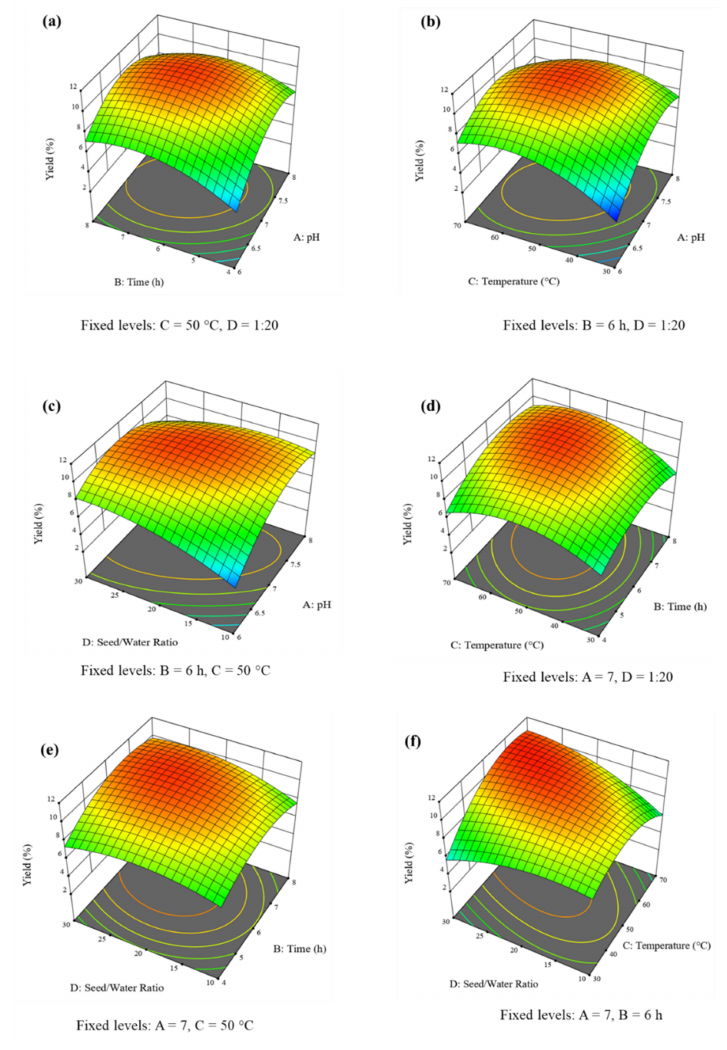
Figure 2. 3D response surface plots pH vs. contact time ( a ), pH vs. extraction temperature ( b ), pH vs. seed/water ratio ( c ), contact time vs. extraction temperature ( d ), contact time vs. seed/water ratio ( e ), and extraction temperature vs. seed/water ratio ( f ), showing significant interaction effect on the yield of MPM (%) from MP